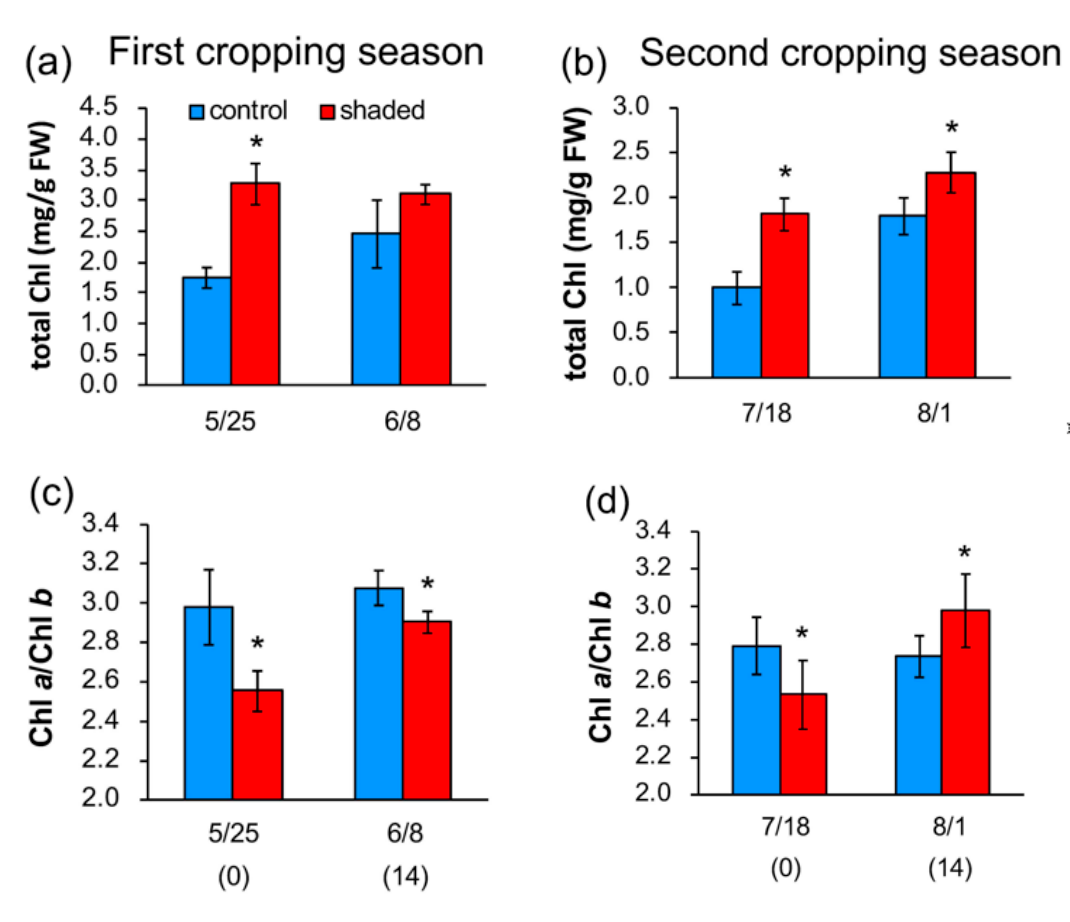
Figure 1. Changes in total Chl content ( a , b ) and Chl a / b ratio ( c , d ) in shaded tea leaves after shade removal. Data from the first ( a , c ) and second ( b , d ) cropping seasons are shown as means ± standard deviation ( n = 5). The x -axis indicates the date of sampling, and numbers in parentheses show the days after shade removal in shaded plants. Asterisks indicate significant differences between the control and shaded plants ( p < 0.05, t